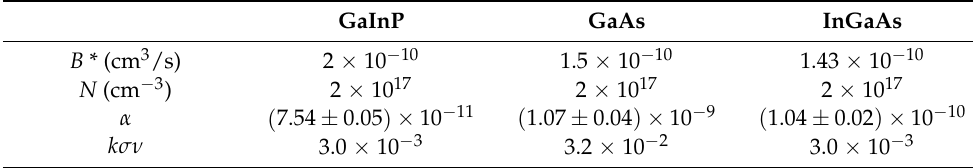
Table 1. The parameters B , N , k σ v and α on GaInP, GaAs and InGaAs subcells. GaInP GaAs InGaAs B * (cm 3 /s)